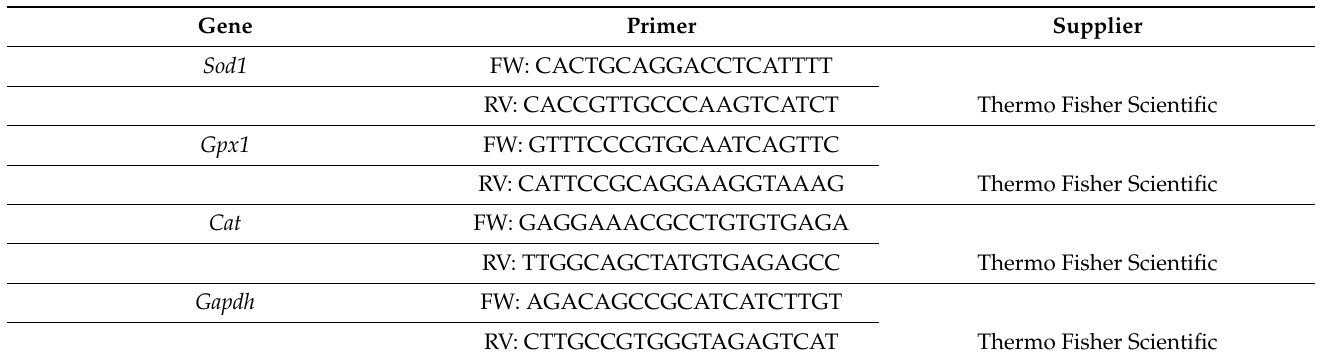
Table 1. List of genes analyzed by RT-qPCR and primer sequences used for transcription amplification.